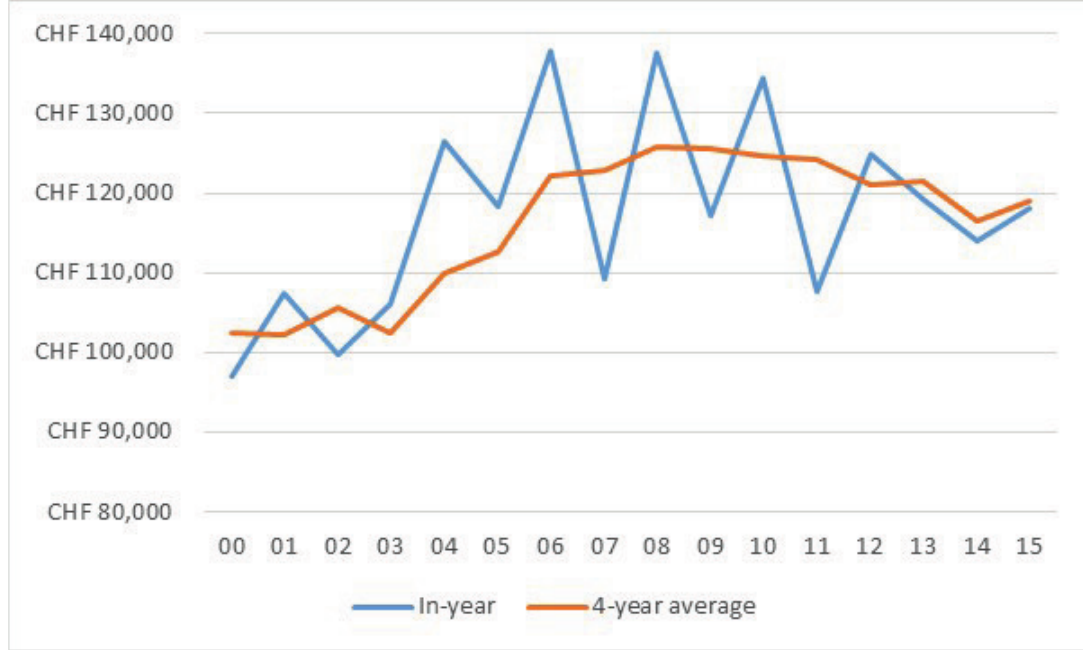
Figure 4: ISPRS membership fees (inc. any arrear payments) collected in-year,